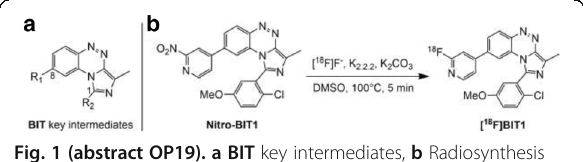
Fig. 1 (abstract OP19). a BIT key intermediates, b Radiosynthesis of [ 18